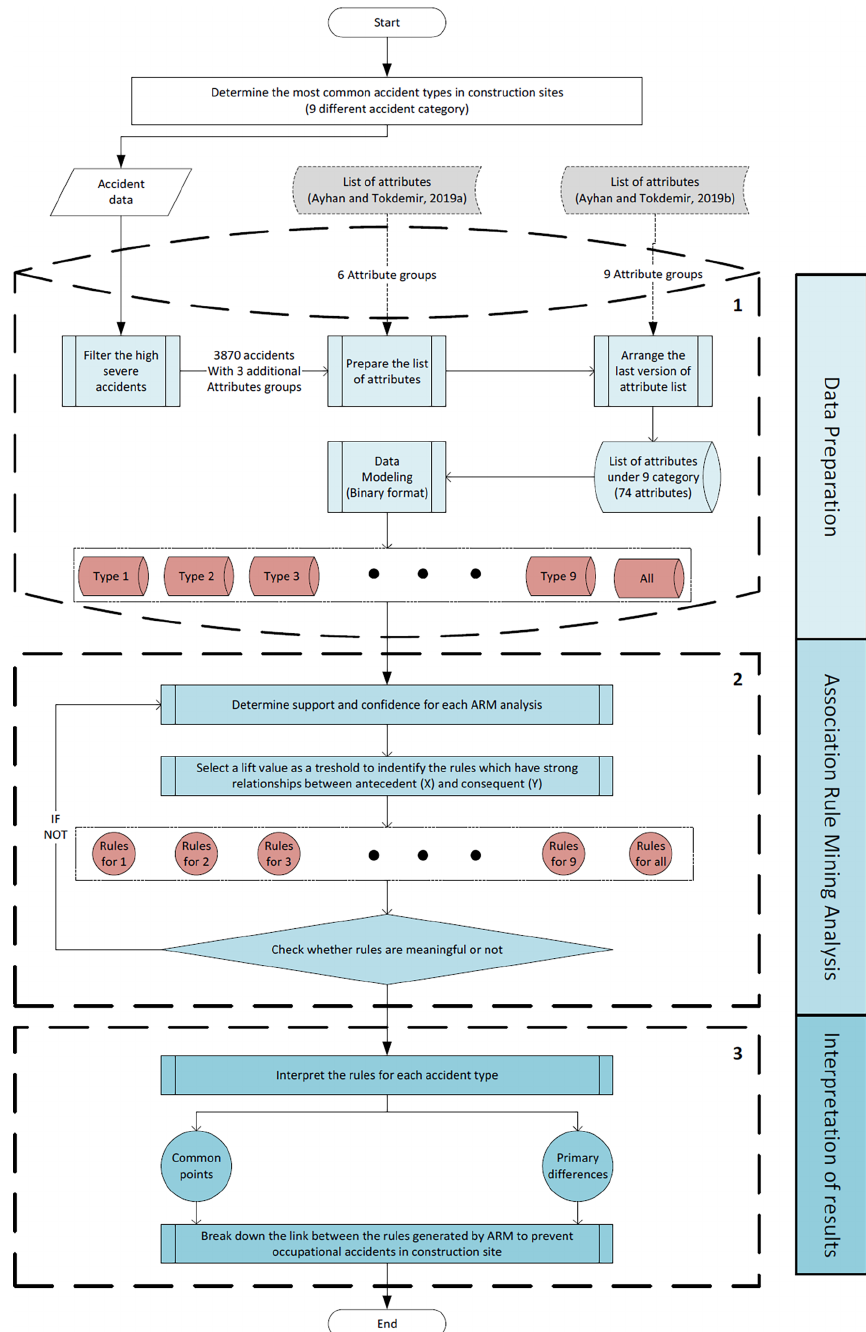
Figure 1. Research plan and